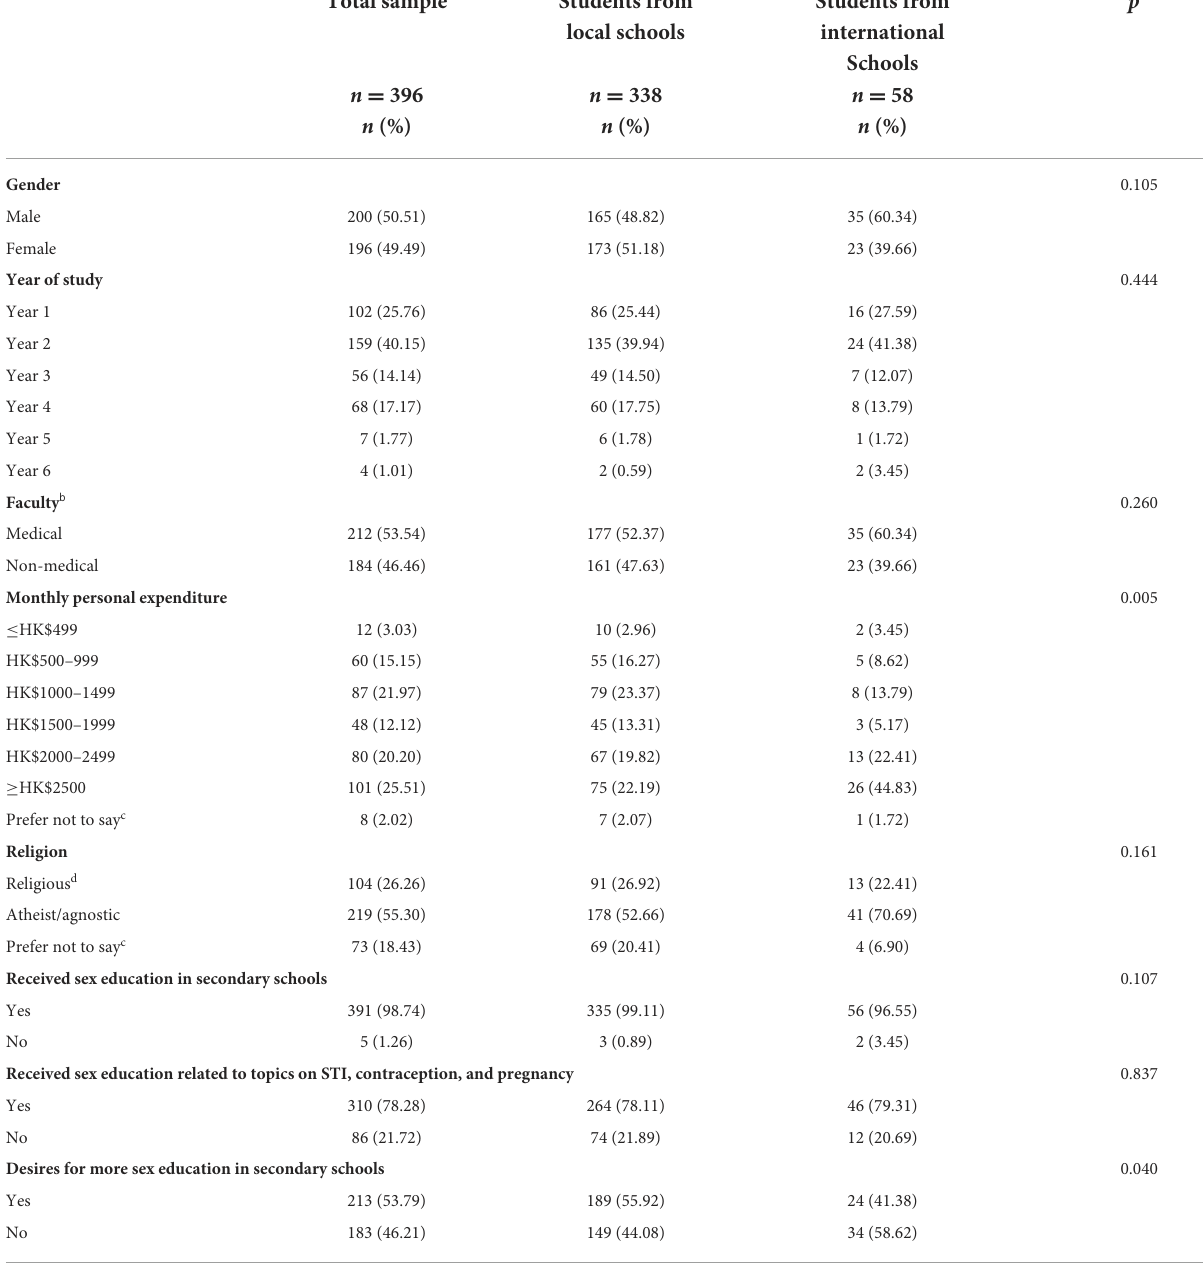
TABLE 1 Comparisons of characteristics between students from international schools and those from local schools. Total sample Students from Students from local schools international